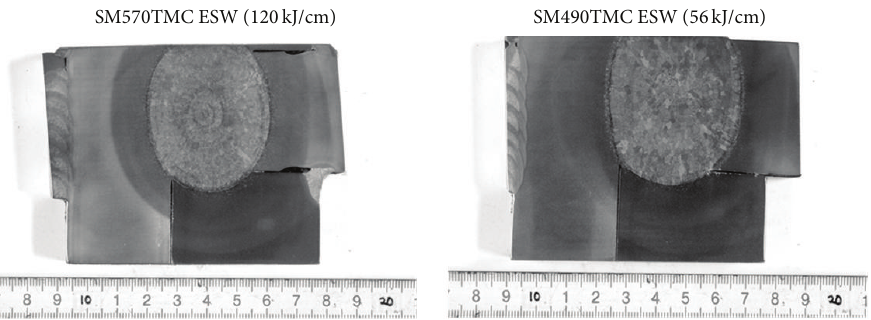
Figure 10: Macro test result of ESW welding for SM490TMCP and